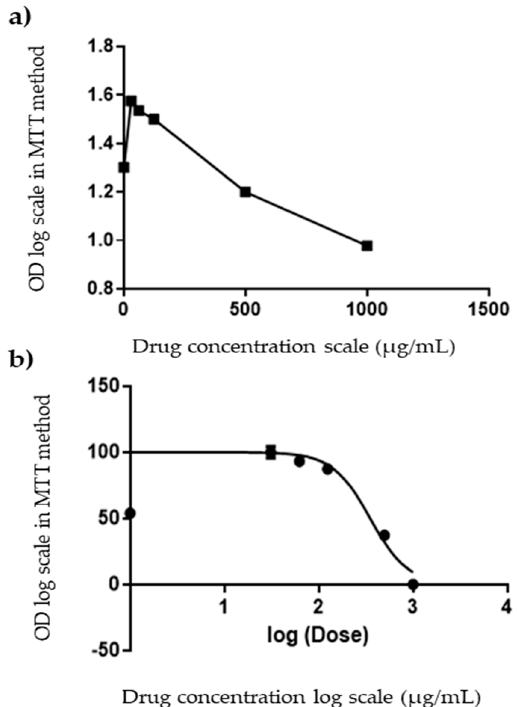
Figure 9. Dose–response curves of M. longipetala extract cell growth inhibition as a percent of control against HepG2 cell lines. ( a ) Transform of the extracted M. longipetala , ( b ) Normalization of transform, OD is the absorbance value.